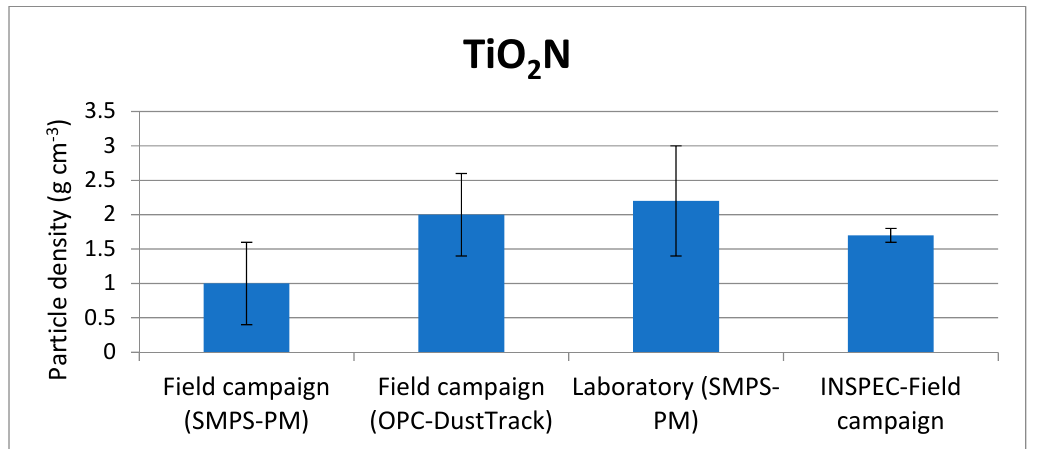
TiO 2 N: The particle density values obtained with the different techniques align with the experimental error (see Figure 5). The average particle density was 1.8 ± 0.5 g/cm 3 (or 2.0 ± 0.1 g/cm − 3 , excluding data of the “Field campaign (SMPS-PM)”, half the theoretical bulk density, as expected considering the porous structure of atomized granules.